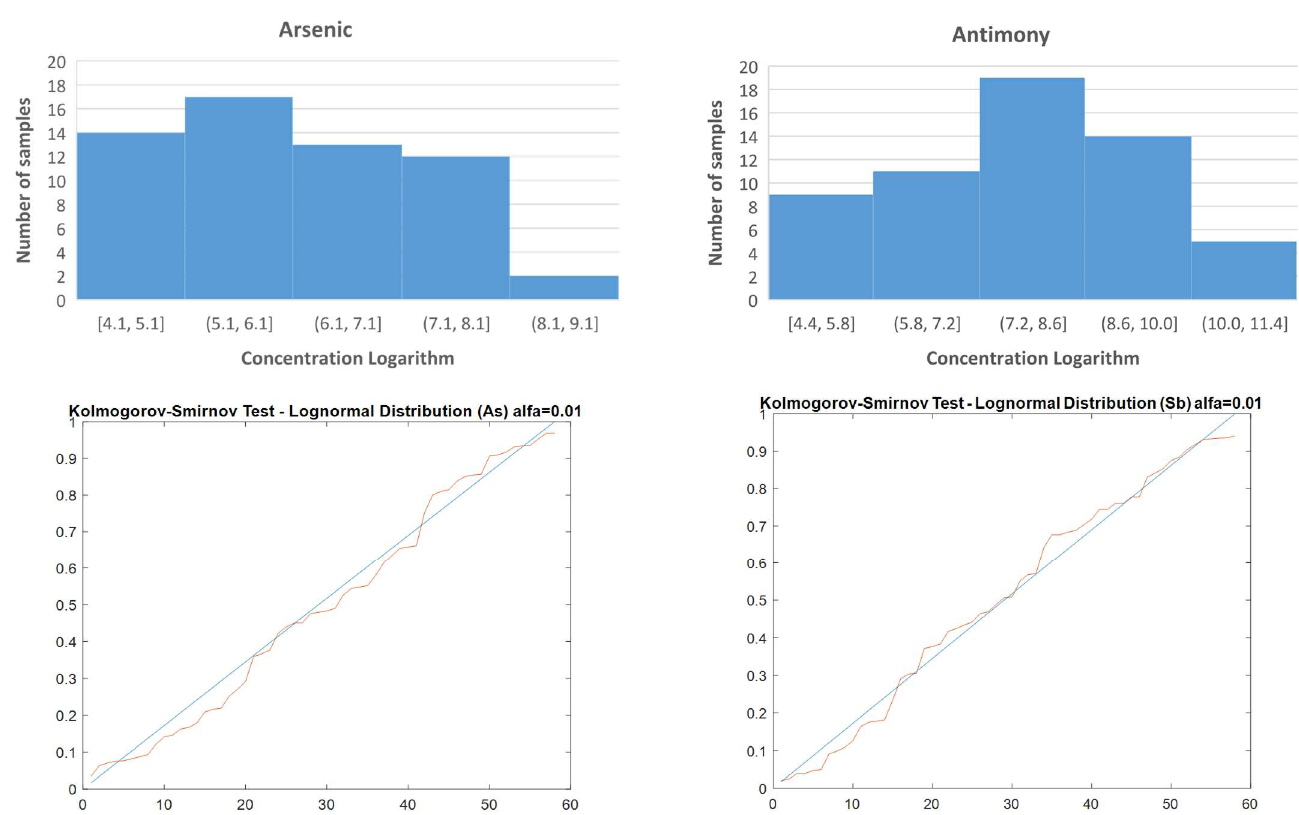
Figure 4. Histograms of the logarithm of the concentrations (As and Sb in ppm) and Kolmogorov– Smirnov Tests. Smirnov Tests.